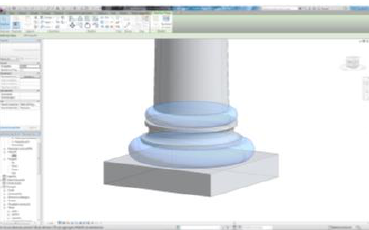
Figure 5. Final HBIM Model of pillar (Garagnani and Manfredini, 2013)